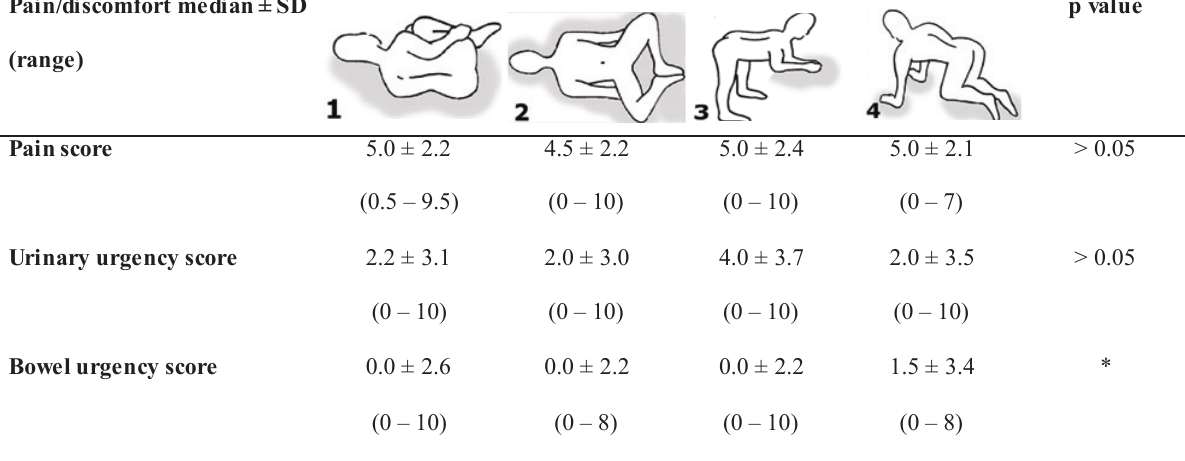
table with the hands; comparison between the other groups, p >